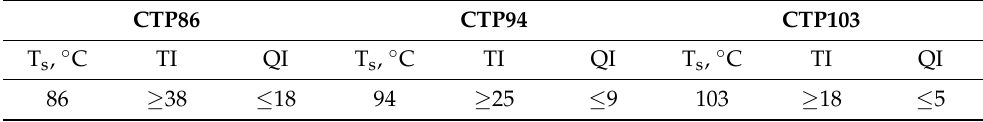
Table 2. The main characteristics of coal tar pitch.